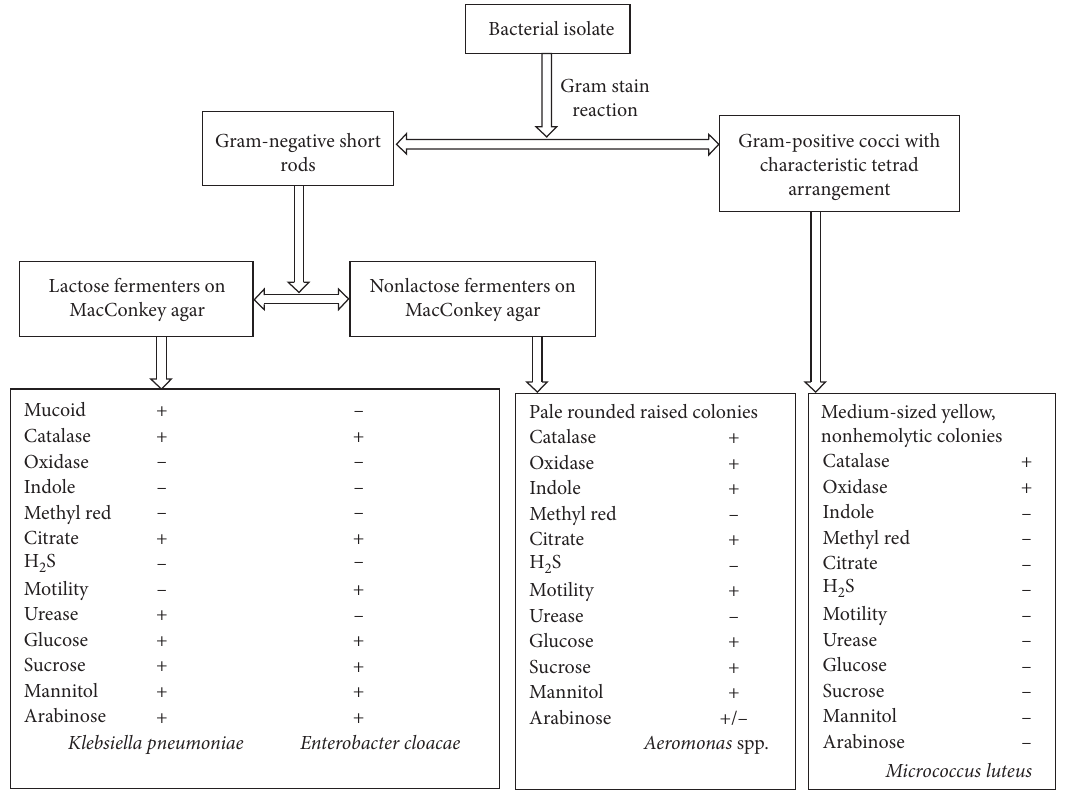
Figure 3: Schematic diagram showing Gram stain reaction, colony morphology, and some biochemical tests used to identify various bacterial